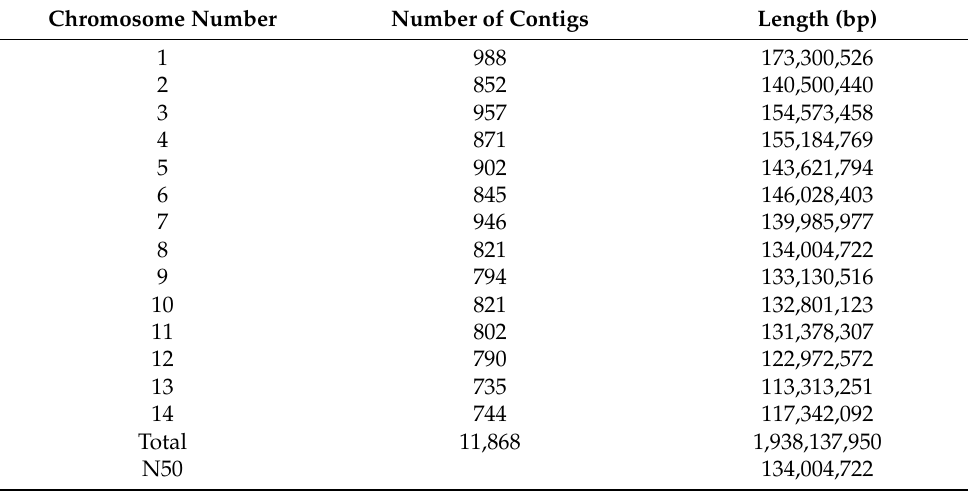
Table 3. De novo assembly of the M. chilensis genome using proximity ligation